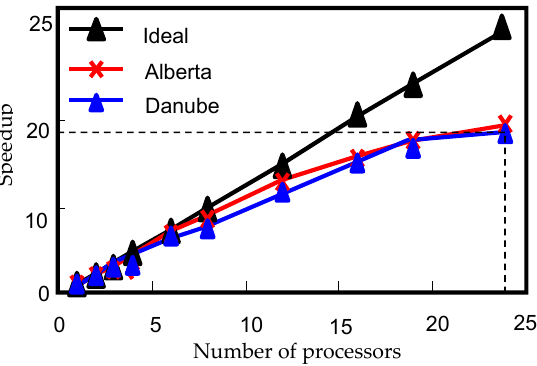
Figure 9. The speed ‐ up achieved for different Soil and Water Assessment Tools (SWAT) projects. The number of processors on the horizontal axis indicates the number of parallel jobs submitted. The